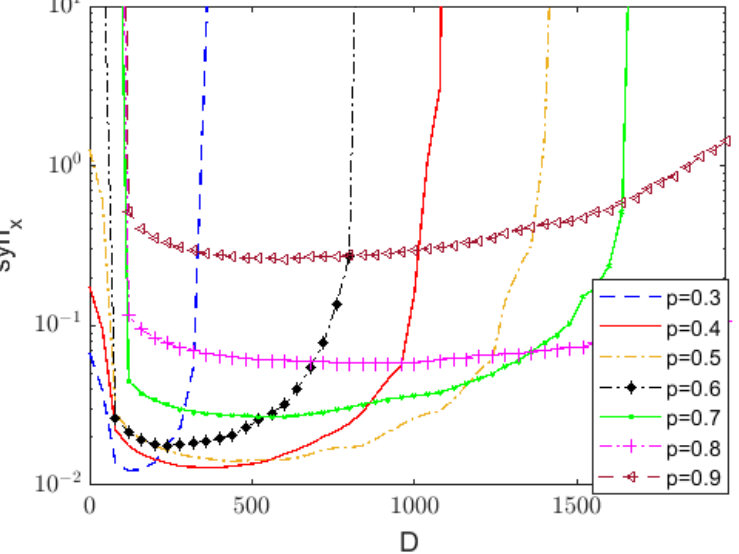
Figure 14. The average position synchronization error Syn x curves of noise intensity D with different fractional-orders p (bounded uniform noise, a = 1, c = − 0.1, and d = − 0.1).